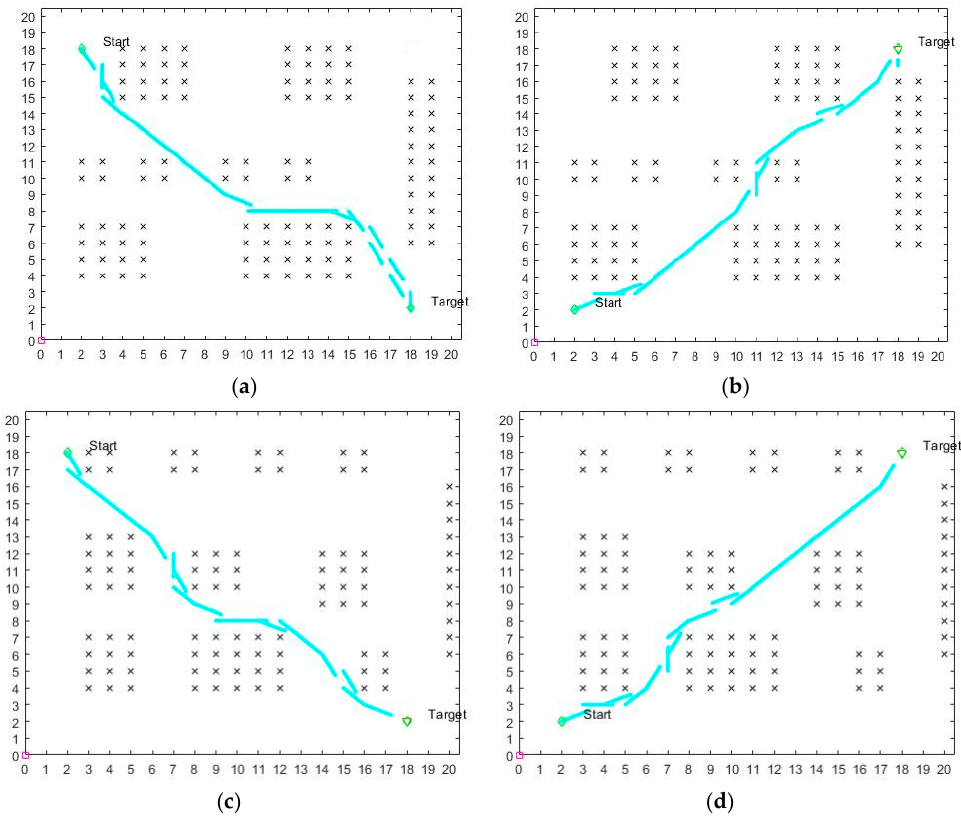
Figure 11. Use of the optimized potential field method in different map environments to set different